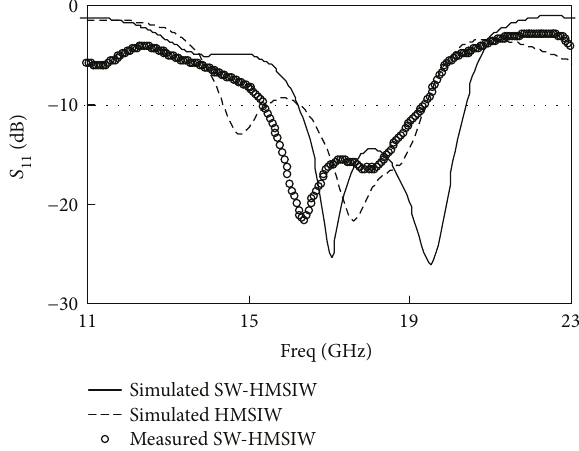
Figure 7: The comparison of | S computed SW-HMSIW, and measured SW-HMSIW-fed Yagi antennas.